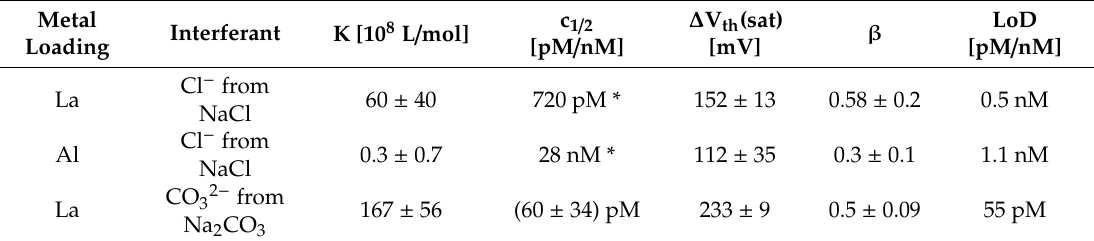
Table 2. Parameters of Langmuir–Freundlich fits to interferant response. K, c 1 / 2 , ∆ V th (sat), β , and LoD for the response of WGTFTs sensitised with La- and Al- / and La-loaded chelating resins to chloride /